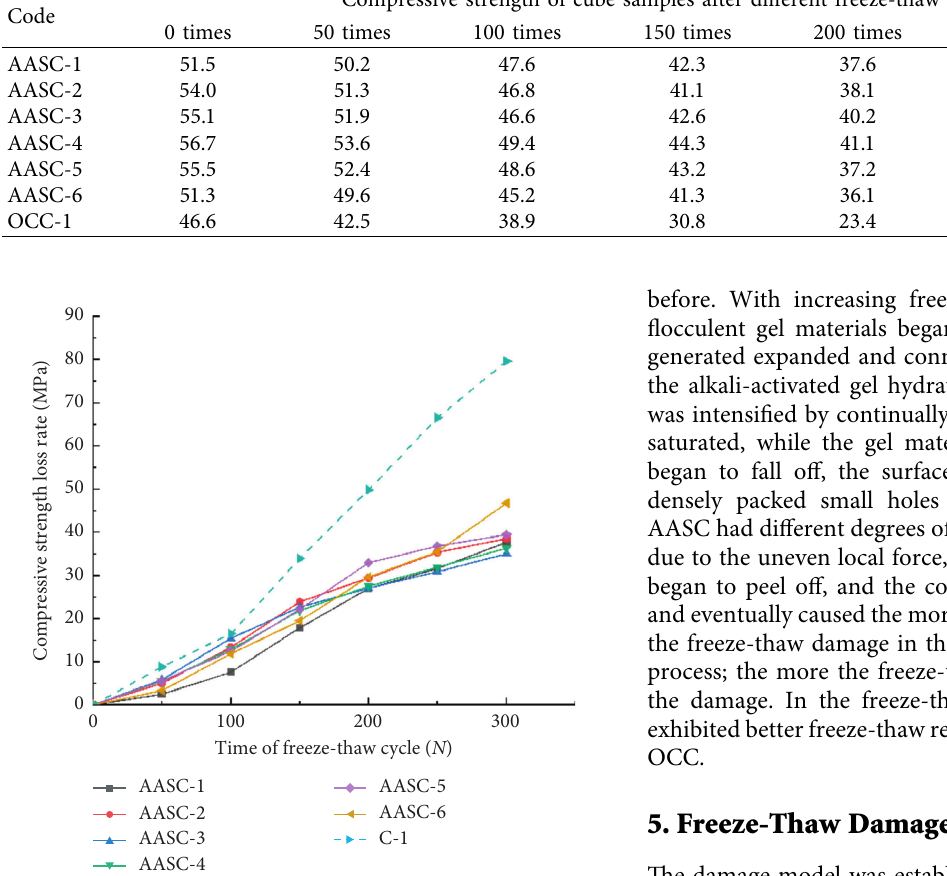
Figure 9: Relation between the compressive strength loss rate and freeze-thaw